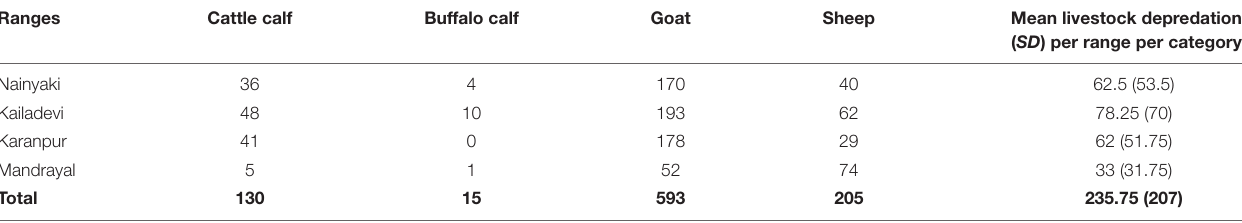
TABLE 3 | Model comparisons for probability of presence-only without depredation ( ψ p ), probability of depredation ( ψ d ), and associated detection probabilities (p pp , p dd , p pd ) in the Kailadevi Wildlife Sanctuary, Rajasthan, India, 2018.